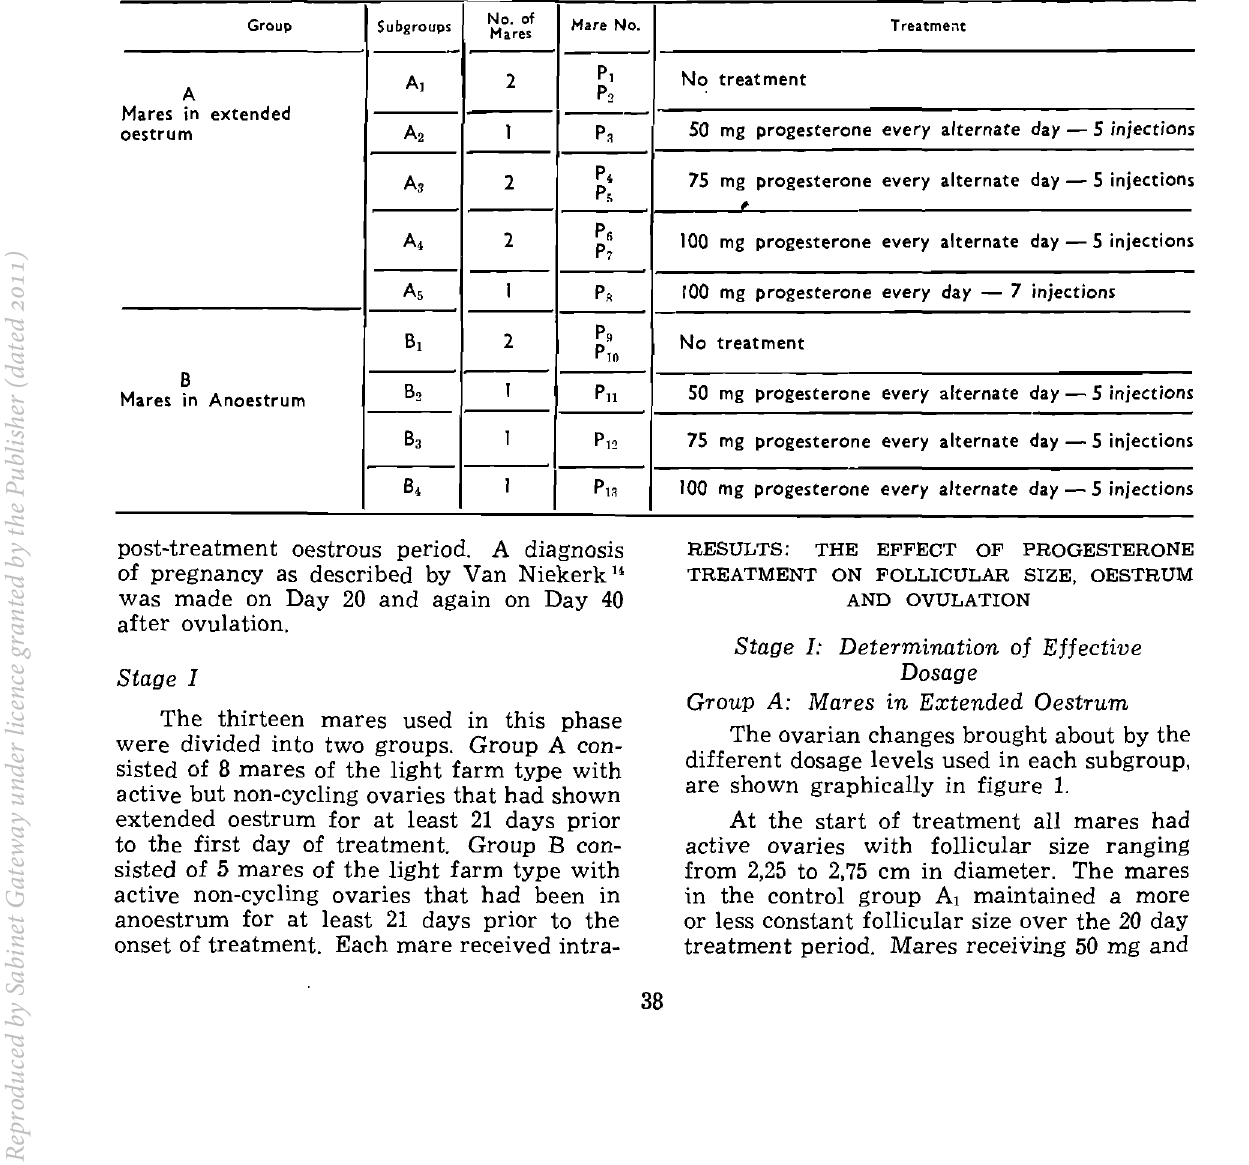
Table I: EXPERIMENTAL DESIGN TO DETERMINE EFFECTIVE DOSAGE LEVEL AND REGIMEN Group